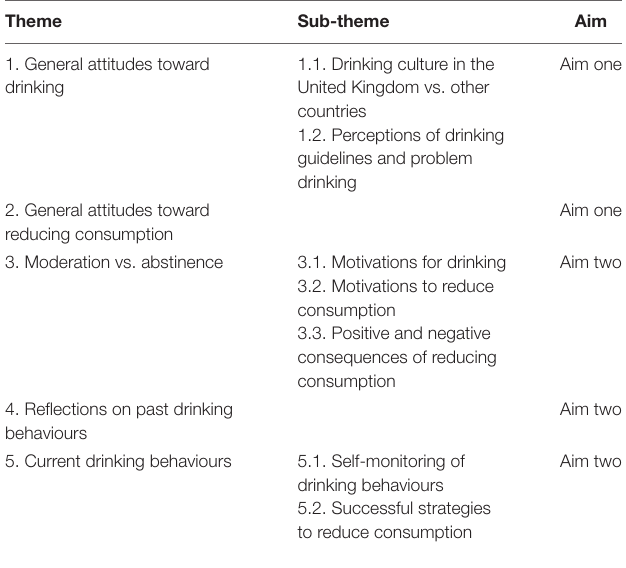
TABLE 1 | Summary of themes and sub-themes with reference to the relevant research